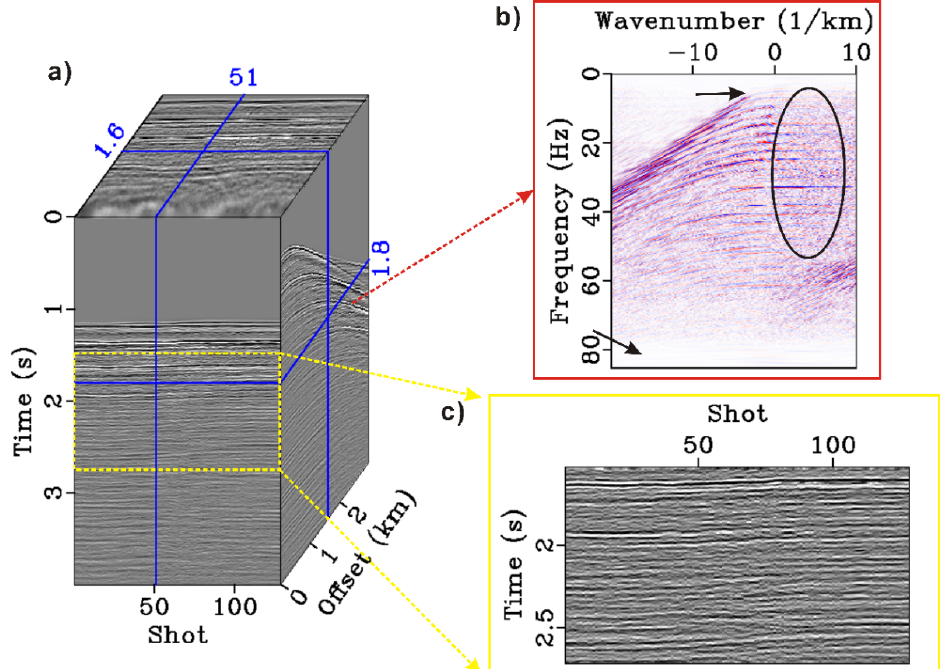
Figure 10. The field data before deghosting. ( a ) 3D data cube including 193 CSGs and 128 COGs. ( b ) f - k spectrum in which the black oval marks the effect of ghost. ( c ) COG wherein the events are similar to the underground interface.